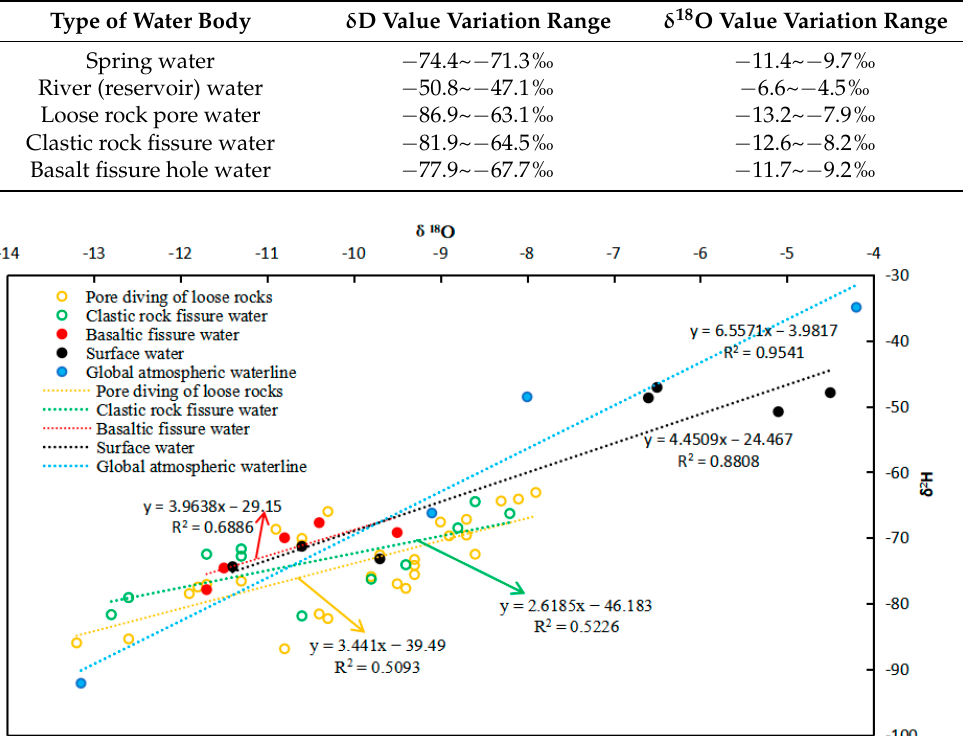
Table 5. Changes of deuterium and oxygen isotope values in different water bodies.